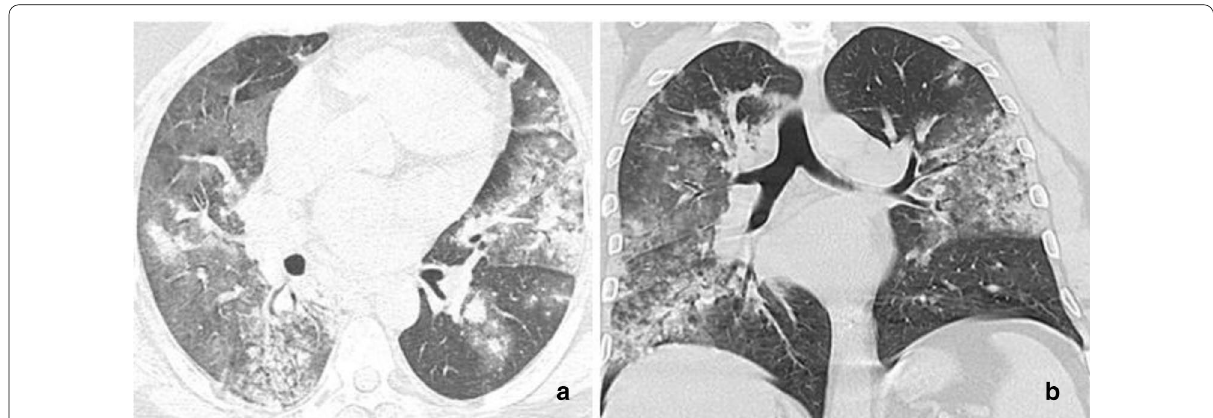
Fig. 4 Viral infection mimicking typical COVID‑19. a , b Axial and coronal reformatted CT image obtained for a 52‑year‑old man with positive PCR test for influenza ( a ) pneumonia show diffuse and multifocal GGO with peripheral consolidation and centrilobular nodules scattered in both lungs